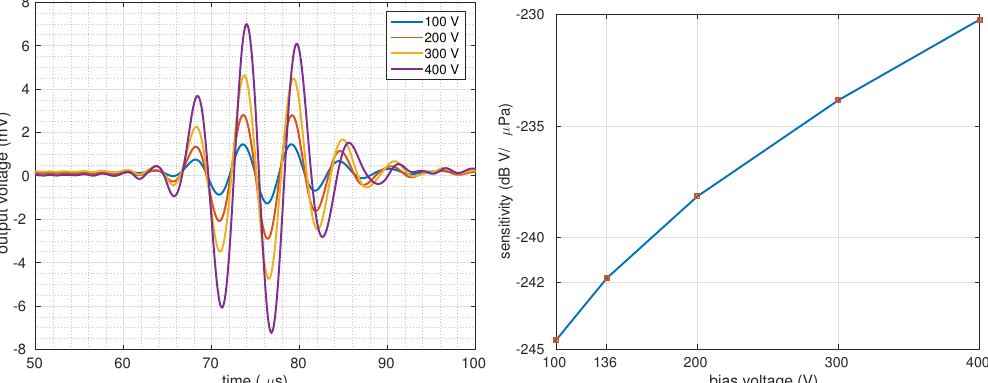
Figure 8. Simulated RX-CMUT output with varying bias voltage ( left ); associated sensitivity ( right